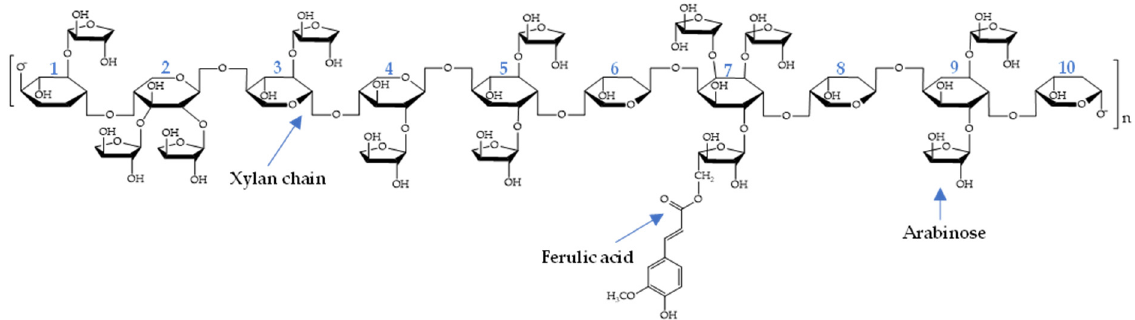
Figure 1. Schematic representations of FA substituent at the AX chain.